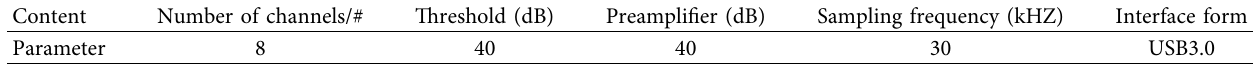
Table 2: Main parameters of DS5 Acoustic Emission System.